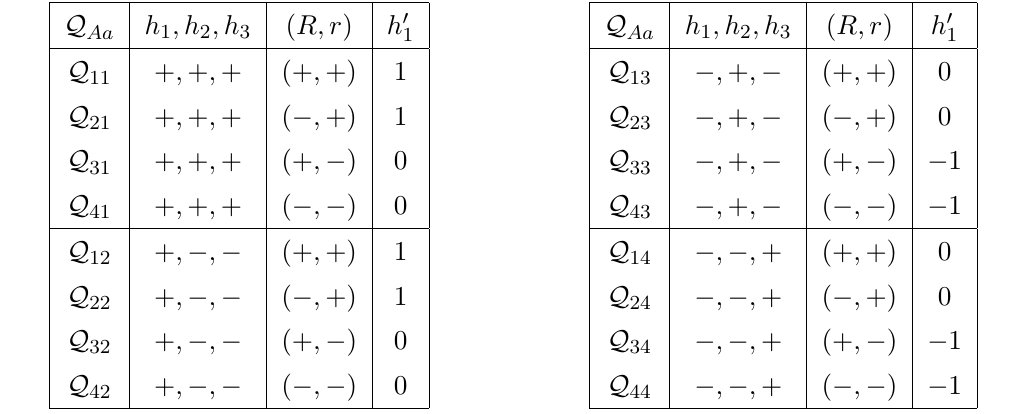
Table 2 . The spins, R-charges and twisted spins of the Poincaré supercharges. All untwisted quantum numbers have magnitude 1 / 2